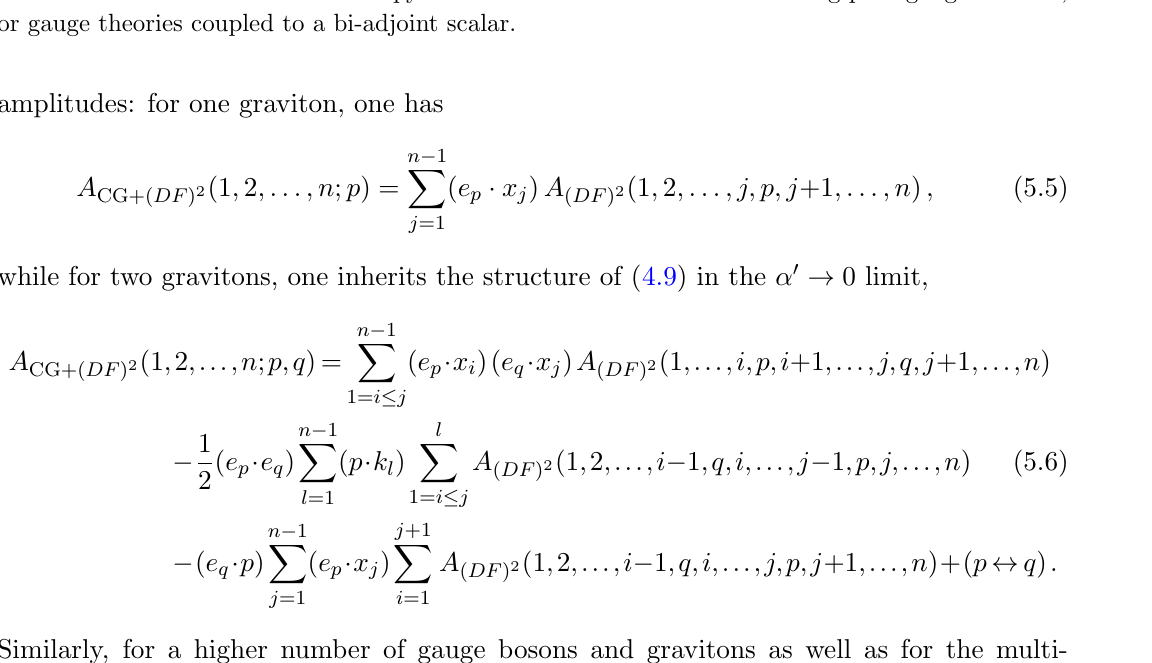
Table 2 . Overview of the double-copy constructions discussed here involving pure gauge theories, or gauge theories coupled to a bi-adjoint